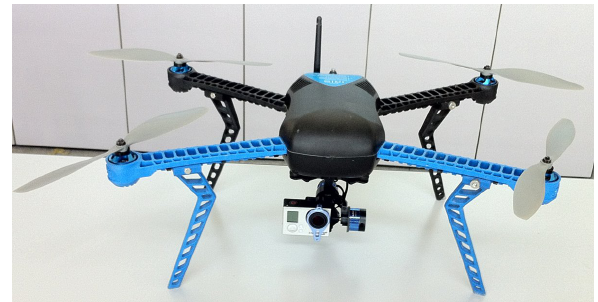
Figure 1: Example of UAV: IRIS 3D Robotics